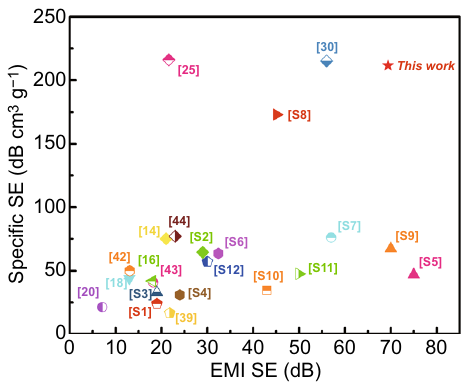
Fig. 9 Comparison of EMI shielding performance of various com- posite foams ever reported